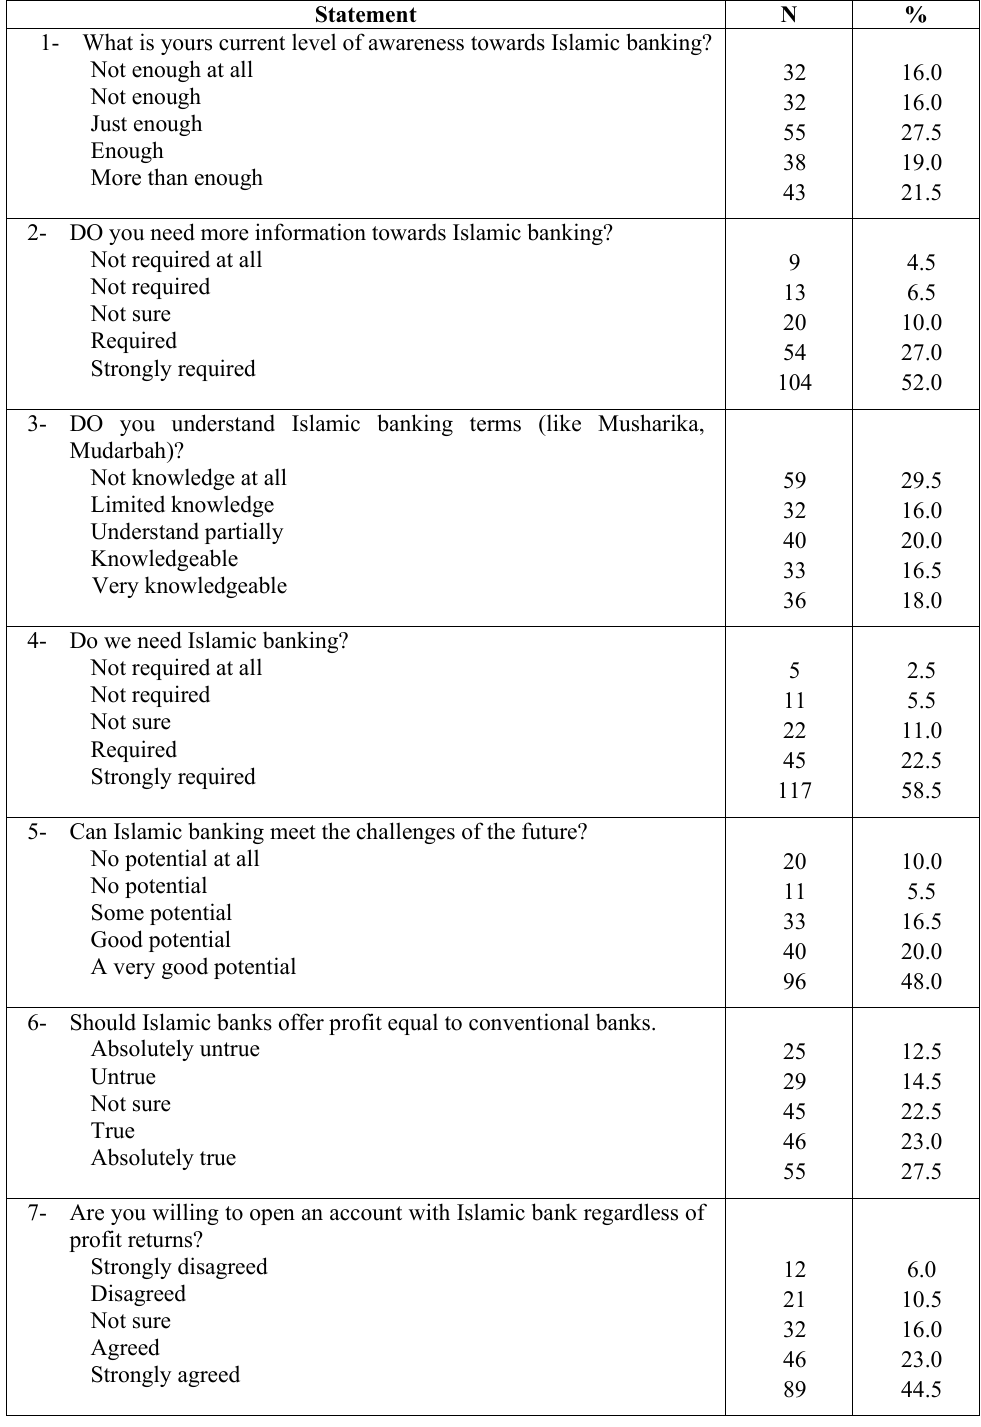
Table 4: Young Customers’ Perceptions towards Islamic